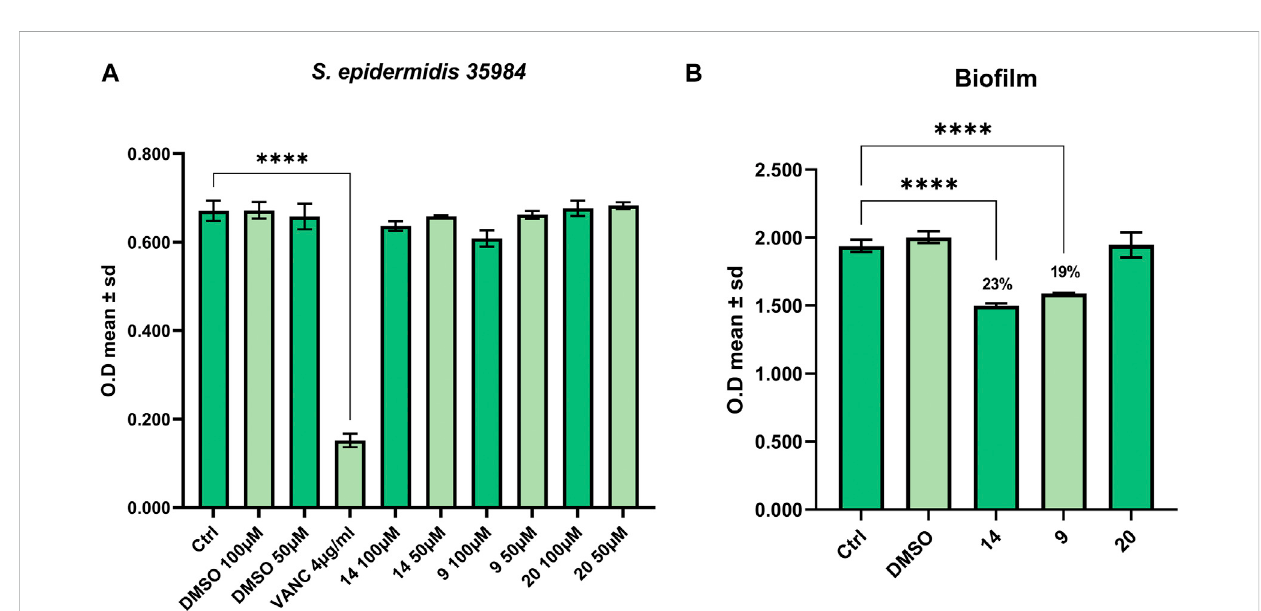
FIGURE 4 Antibacterial activity against (A) S. Epidermidis 35984 and (B) inhibition of bio fi lm